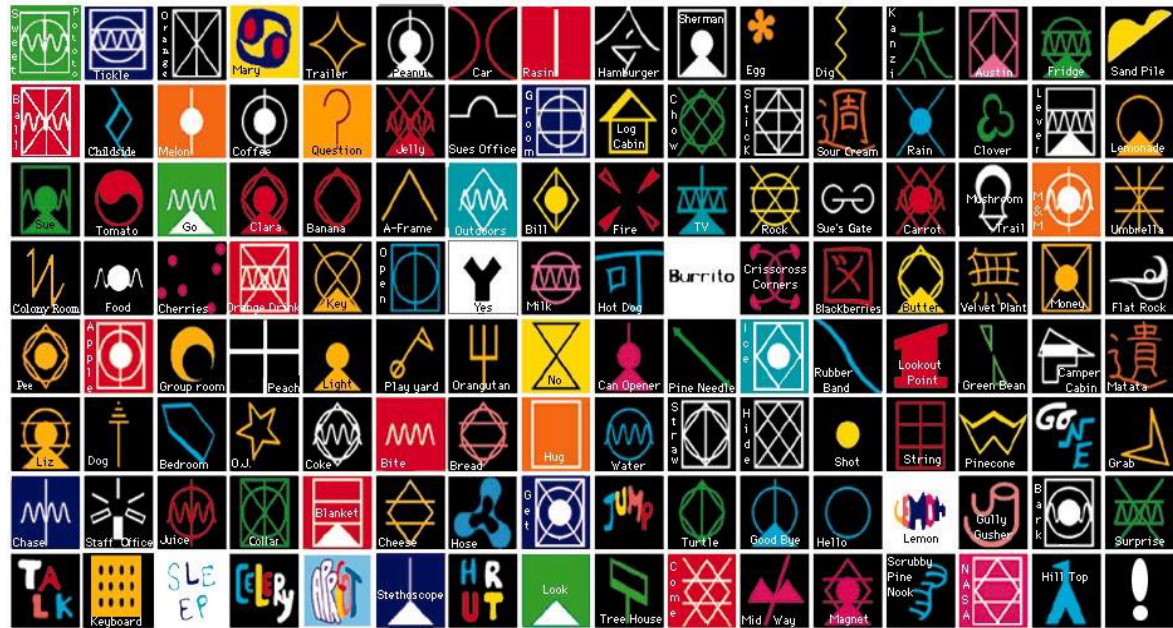
Figure 1 . First panel of the lexigram keyboard used in later studies at the LRC. Photo used with permission from the LRC and Sue